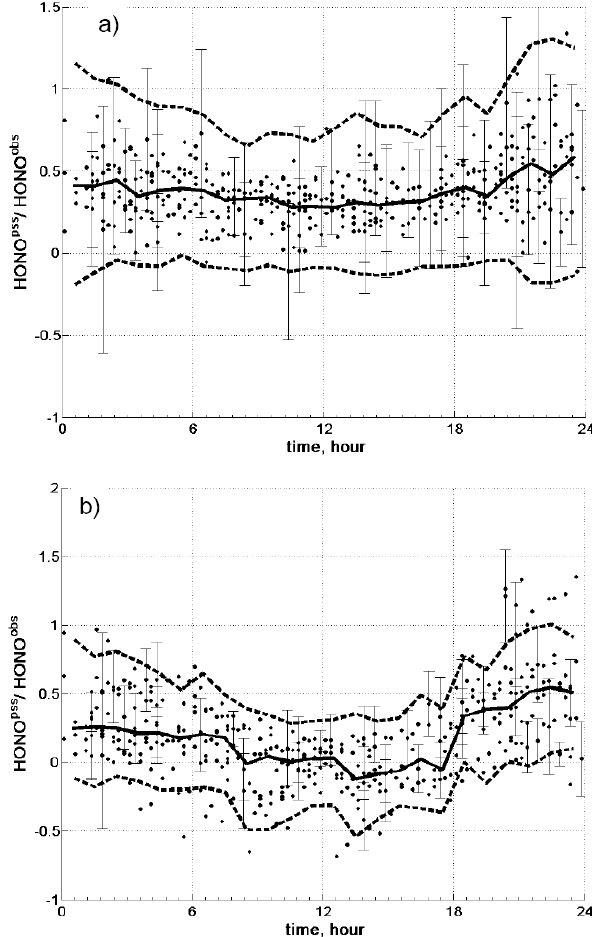
Figure 9. Ratio of calculated and measured [HONO]: (a) from OH budget; (b) from net radical (OH and RO 2 ) sources and sinks. Solid lines – median values; dashed lines – upper and lower quartiles of the mean values with added and subtracted standard deviation, re- spectively. Error bars correspond to standard deviation.